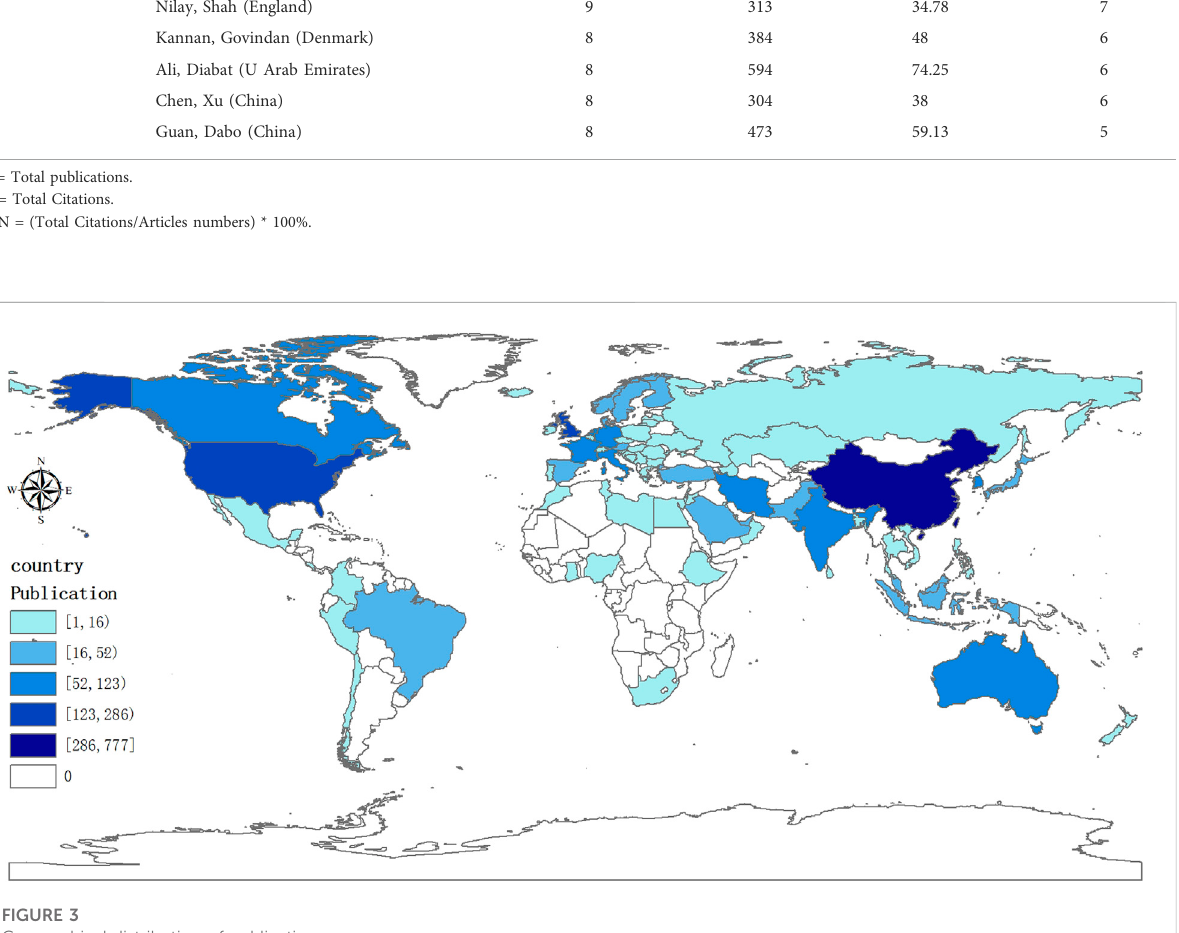
FIGURE 3 Geographical distribution of